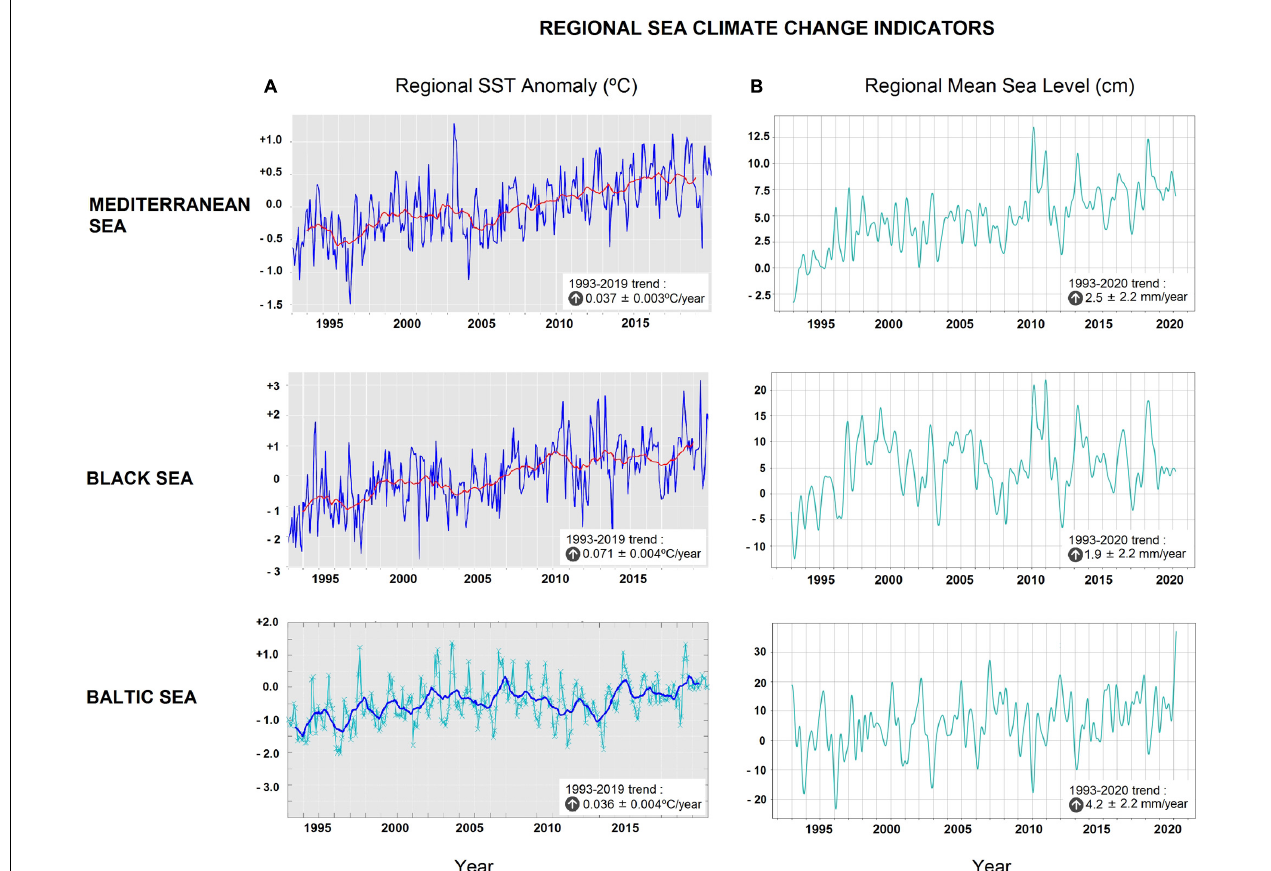
FIGURE 13 | (A) Time series of regional Sea Surface Temperature (SST) anomalies ( ◦ C) during the period January 1993–December 2019 (27 years) in the Mediterranean Sea, the Black Sea and the Baltic Sea. Mediterranean and Black Sea: blue line (monthly mean) and red line (24-month filtered). Baltic Sea: green crosses (monthly mean) and blue line (1 year trends). The anomalies are relative to the climatological period 1993–2014. (B) Time series of regional daily Sea Level (cm) during the period January 1993–February 2020 (27 years) in the Mediterranean Sea, the Black Sea and the Baltic Sea. Altimetric data derived from the average of gridded sea level maps weighted by the cosine of the latitude. The time-series are low-pass filtered, the annual and semi-annual periodic signals adjusted, and the curve corrected for the Glacial Isostatic Adjustment (GIA; Peltier, 2004). Individual figures credited to EU Copernicus Marine Service